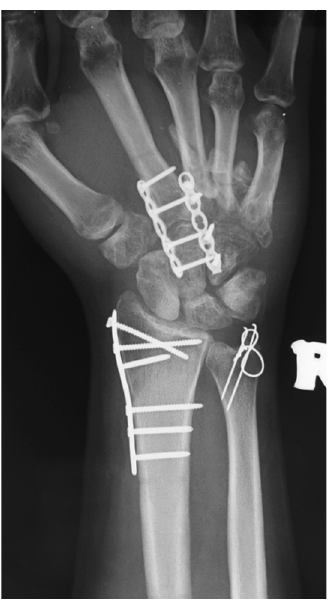
Radiograph shows the configuration of bones of Fig. 3: patient's right hand after